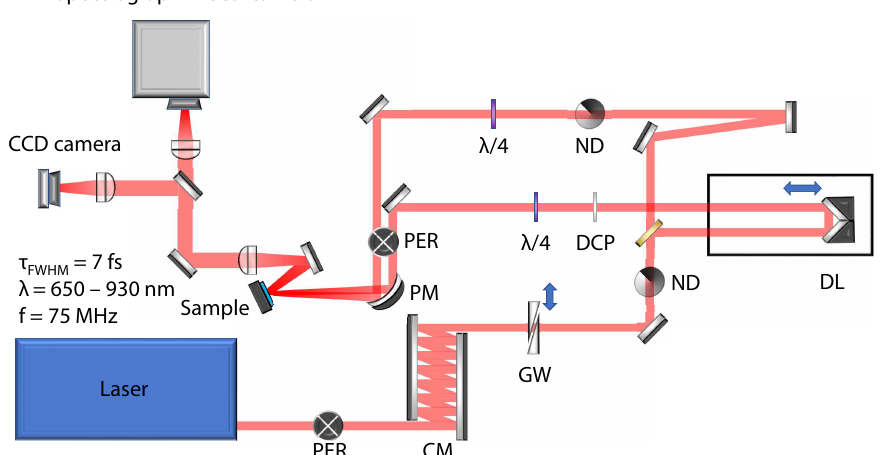
Figure 1. Detailed layout of the experimental setup. Laser—Ti:sapphire laser oscillator Rainbow (Femtolasers/Spectra Physics), λ /4—achromatic quarter-wave plate, PER—periscope, CM—chirped mirrors, GW—glass wedges, ND—neutral densit filter, DCP—dispersion compensating plate, DL—delay line, PM—parabolic